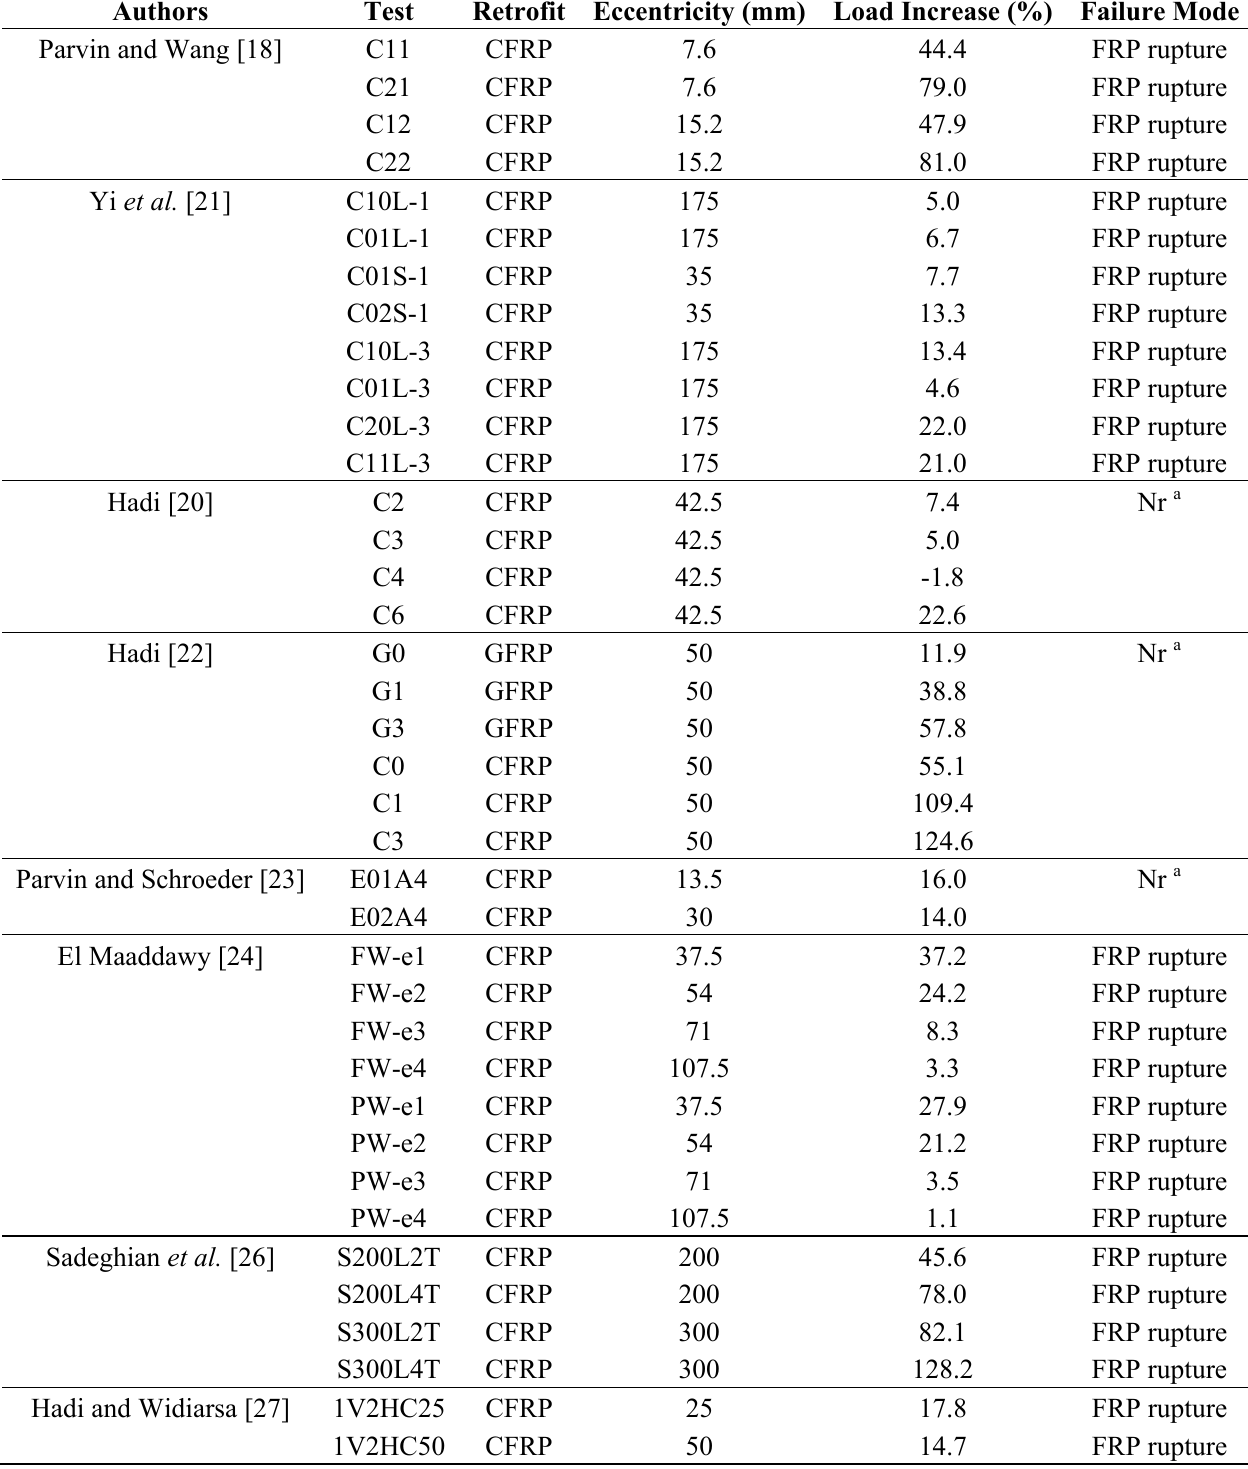
Table 2. Representative data on FRP-retrofitted eccentrically loaded